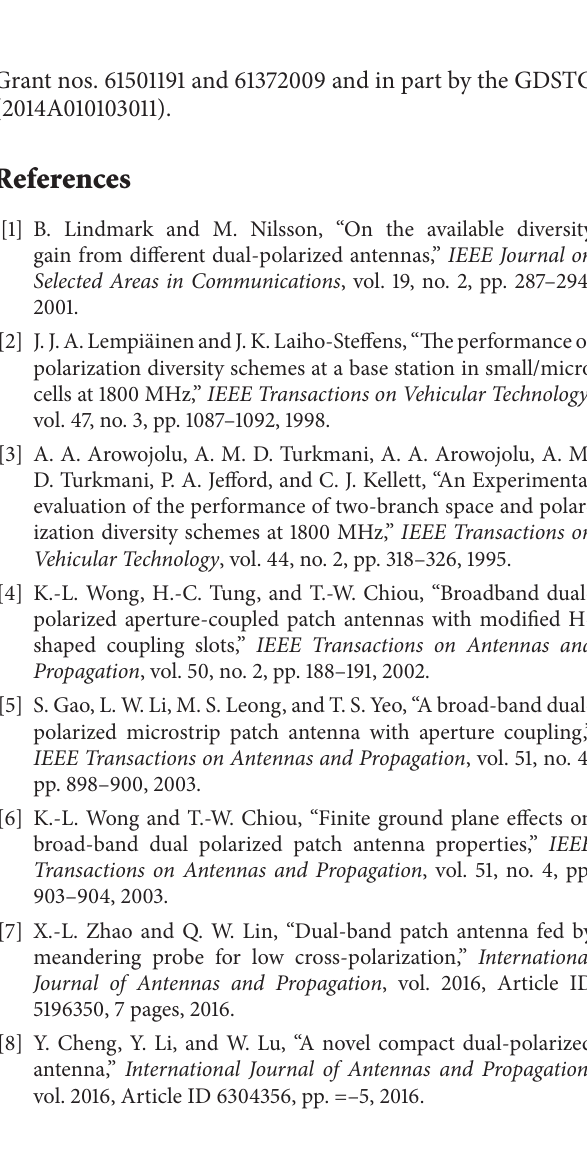
Figure 11: Front-to-back ratios and antenna efficiency of the V/H dual-polarized antenna